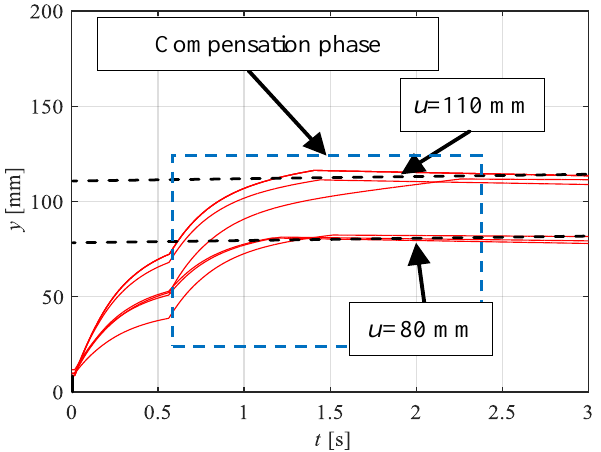
Figure 10. The electrohydraulic drive y position for the selected position values at the supply p 0 of 5, 9 and 11 MPa (taken from the reference magnetostrictive pressure p 0 of 5, 9 and 11 MPa (taken from the reference magnetostrictive sensor).